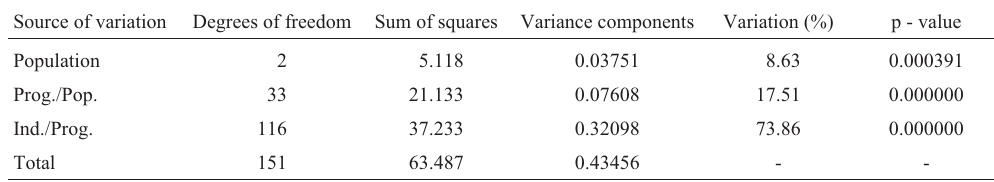
Table 5 - Analysis of molecular variance (AMOVA) and fixation indexes* for 152 individuals in three Eugenia dysenterica DC populations from northeastern Goiás, Brazil. Source of variation